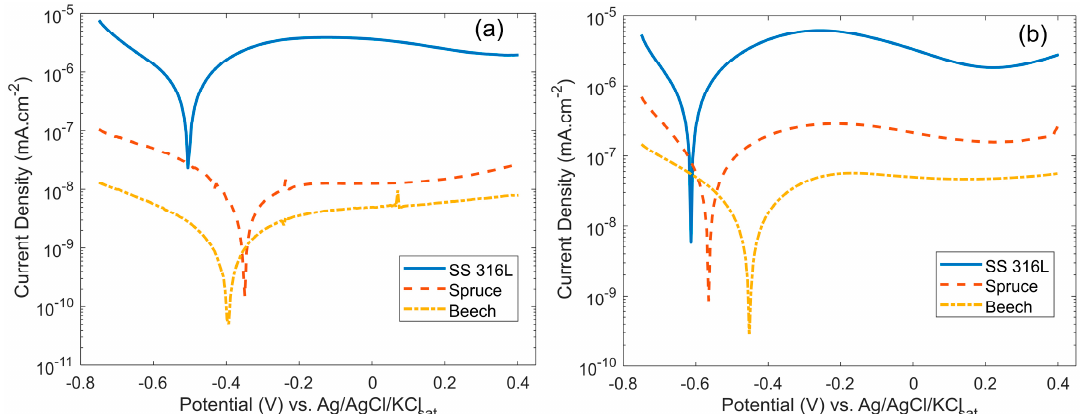
Figure 4. Linear sweep voltammograms of samples after 0 min ( a ) and 90 min ( b ) exposure to simulated body fluid (SBF) solution (sweep rate: 25 mV·s − 1 ).